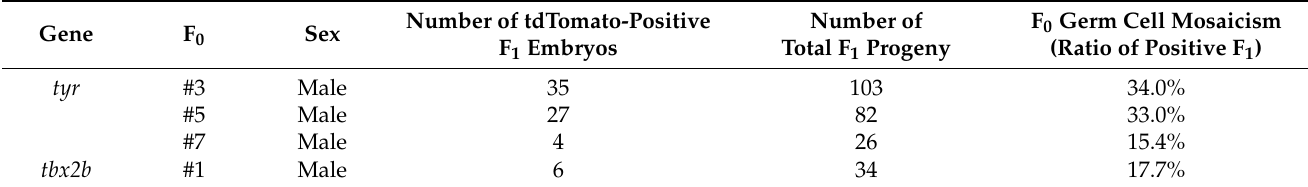
Table 1. Germline transmission of ErCas12a MMEJ knockin positive F 0